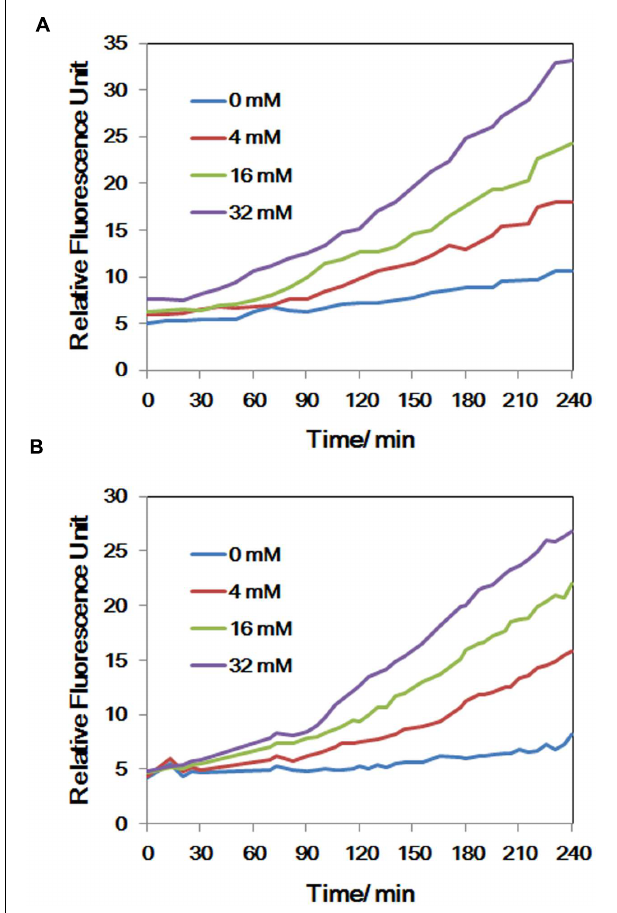
FIGURE 4 | (A) The concentrations of NO of LSJC7 exposure to 0, 4, 16, and 32 mM As; (B) The concentrations of ROS of LSJC7 exposure to 0, 4, 16, and 32 mM As. Results are shown as means of three